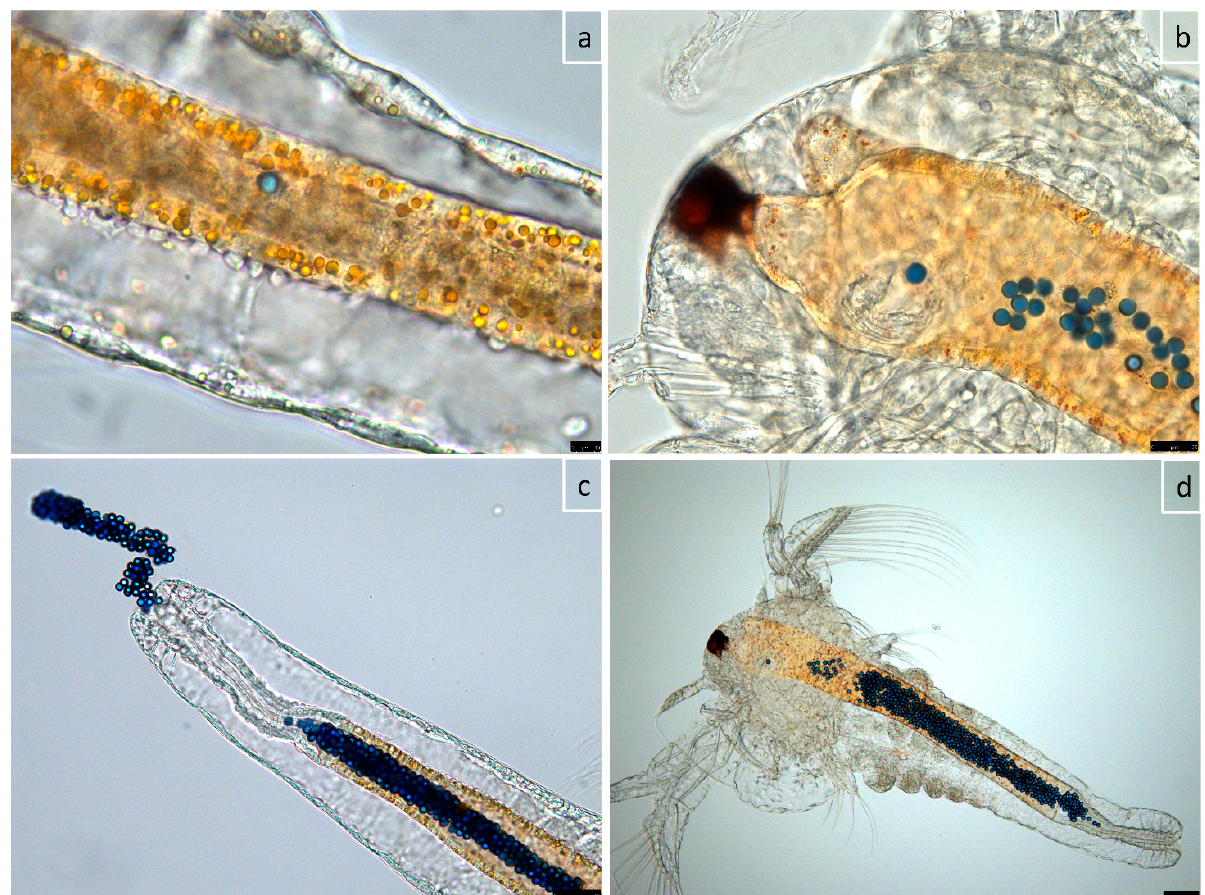
Figure 3. Ten µ m of Polybead ® Blue Dyed Microspheres detected in the gut and feces of Group B specimens at T48. ( a ) Treatment B1 (1 MPs/mL); ( b ) treatment B4 (10 3 MPs/mL); ( c , d ): treatment B5 (10 4 MPs/mL). Scale bars: 10 µ m ( a ); 25 µ m ( b ); 50 µ m ( c ); 75 µ m ( d ). Table 2. Ingested microplastics counted for each experimental group (A and B) and exposure time. Data are shown as means ± SD ( n = 3). Exposure Time Experimental Groups